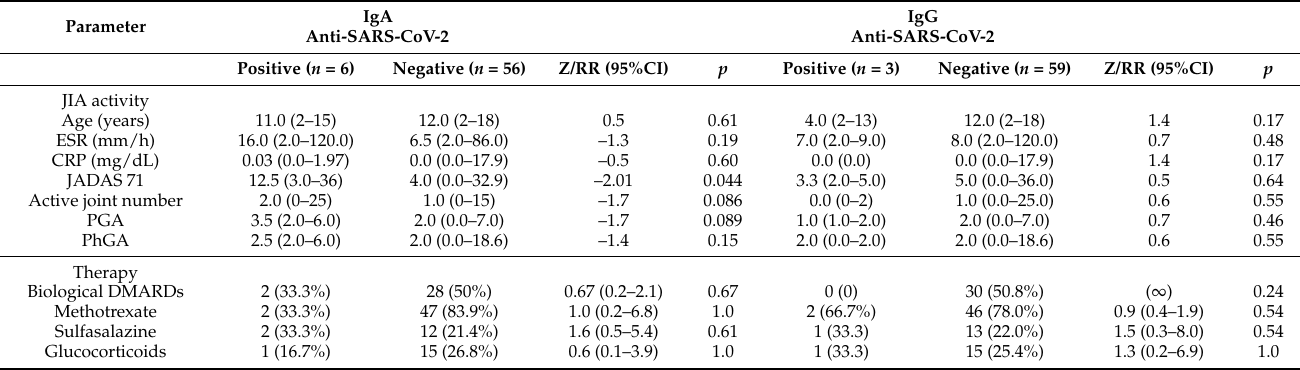
Table 2. Characteristics of JIA patients who are seropositive and seronegative for